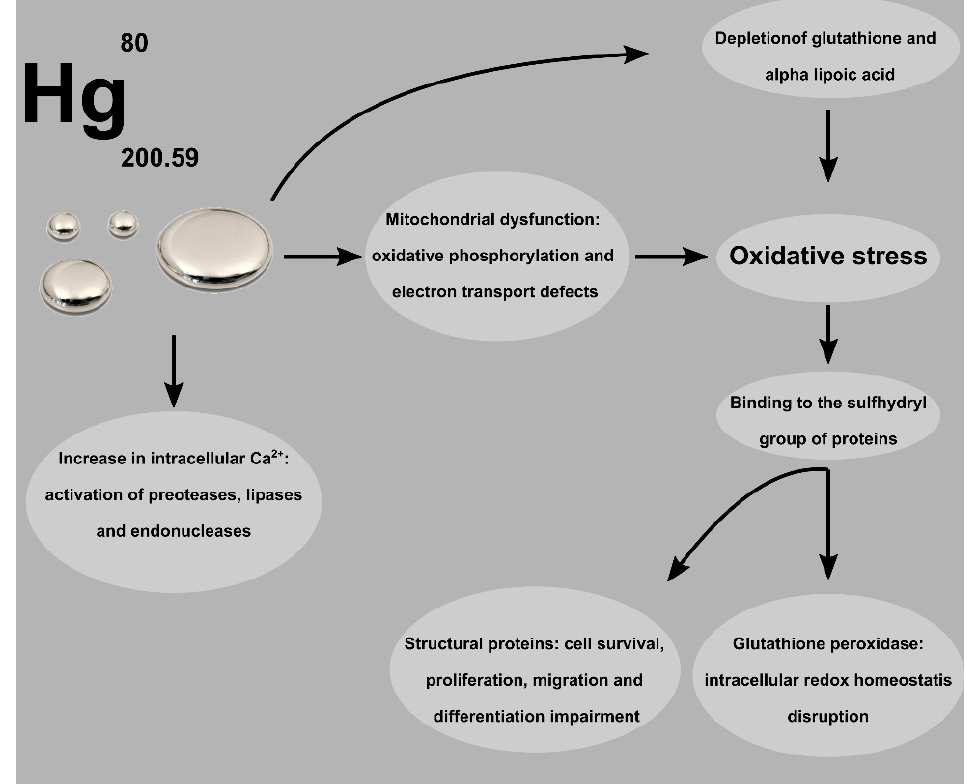
Figure 2. Mechanisms of toxicity associated with Hg exposure, most of which lead to oxidative